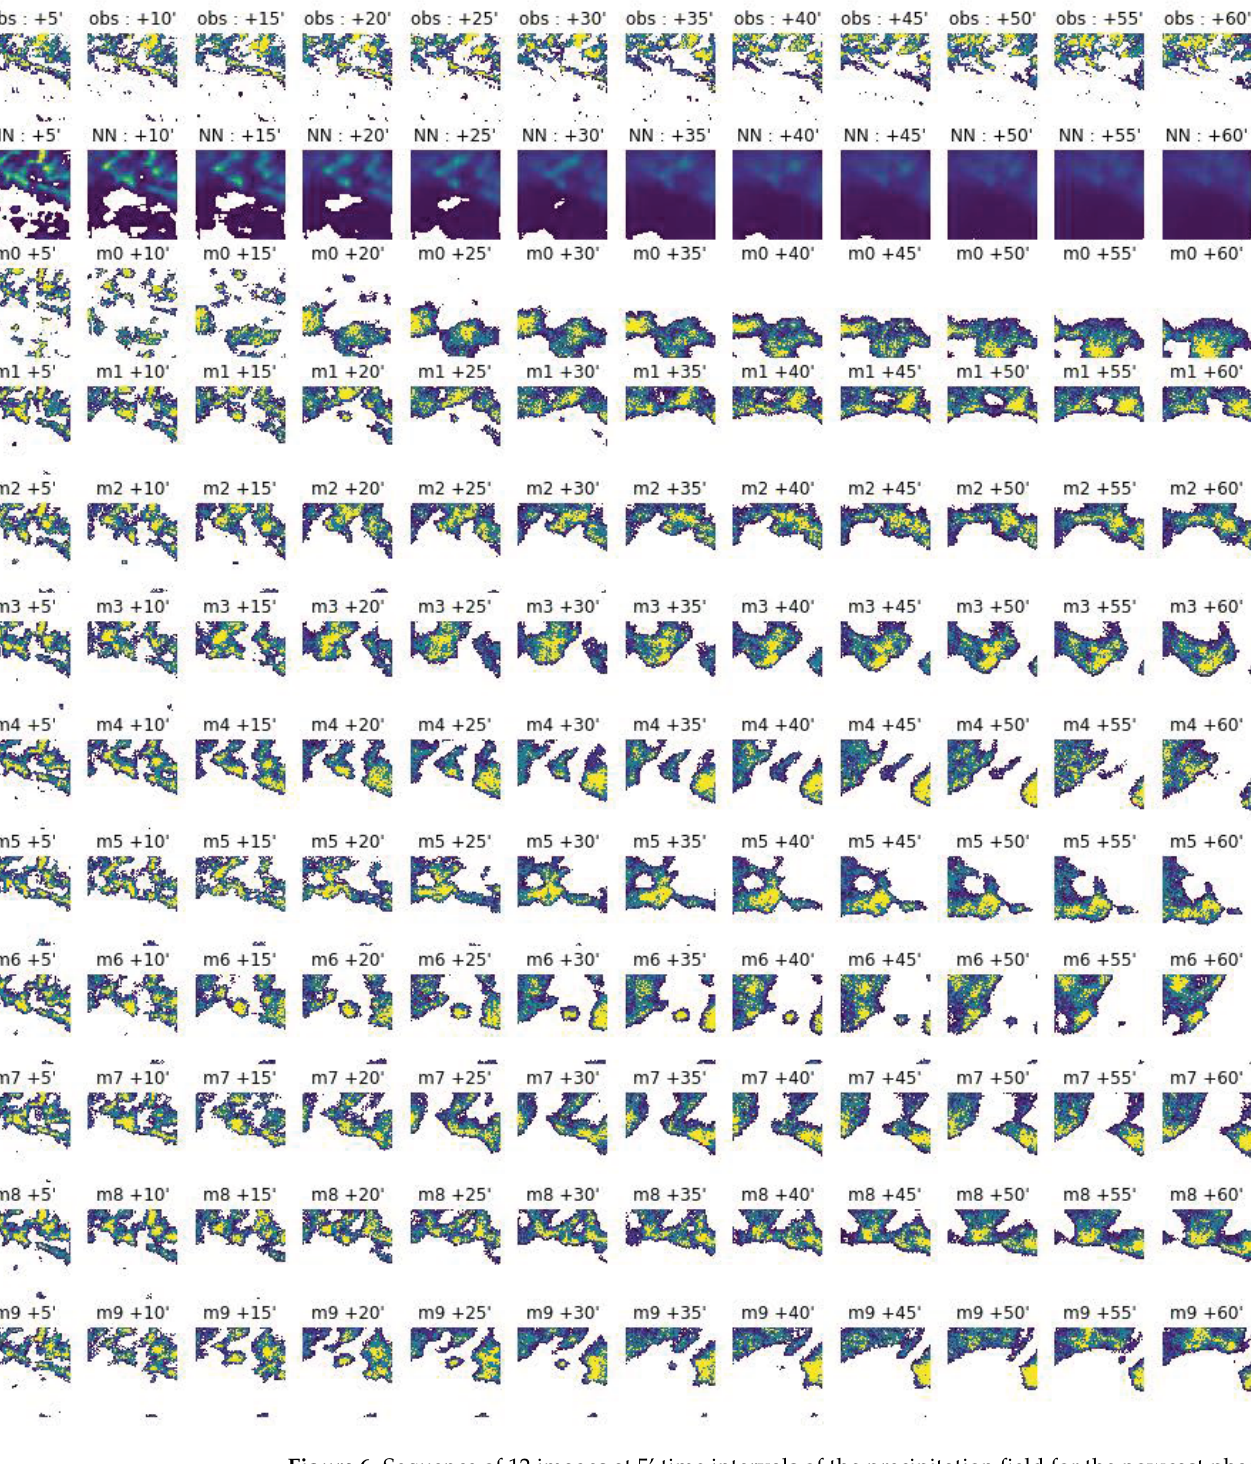
Figure 6. Sequence of 12 images at 5’ time intervals of the precipitation field for the nowcast phase. The first row ( obs ) shows the observed data, the second the deterministic unperturbed nowcast ( NN ) and the next 10 rows ( m0 to m9 ) the nowcast of 10 perturbed